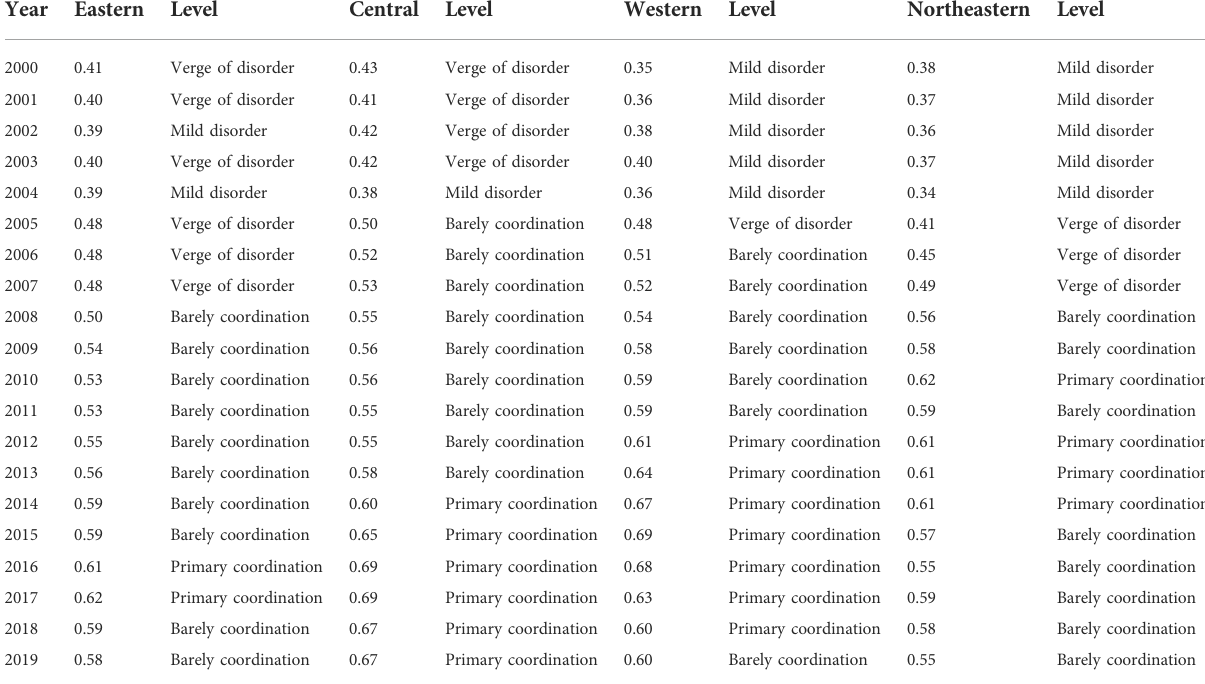
TABLE 4 Coupling coordination degree of four